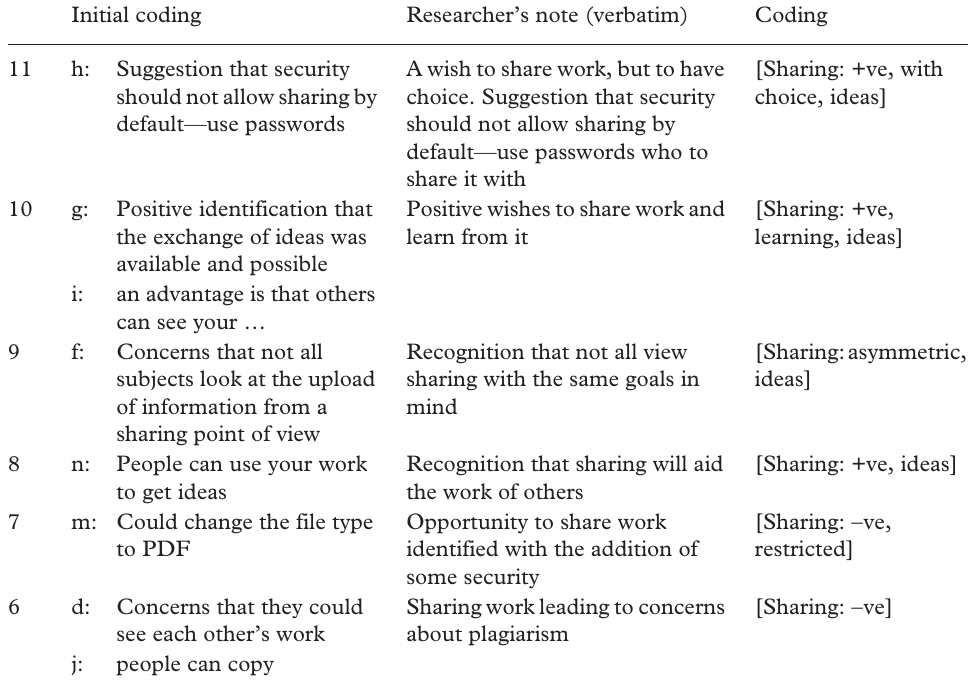
Table 3. Sharing sequenced in decreasing levels with structured